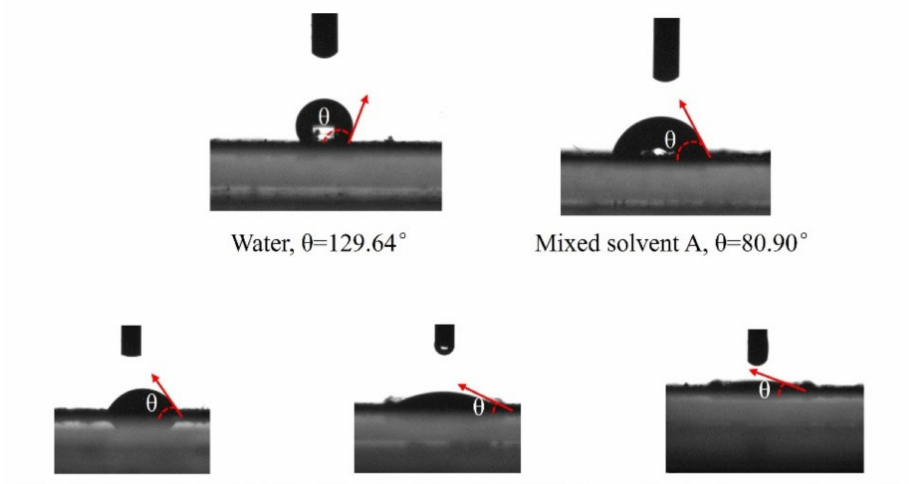
Figure 2. Contact angles of different solvents with